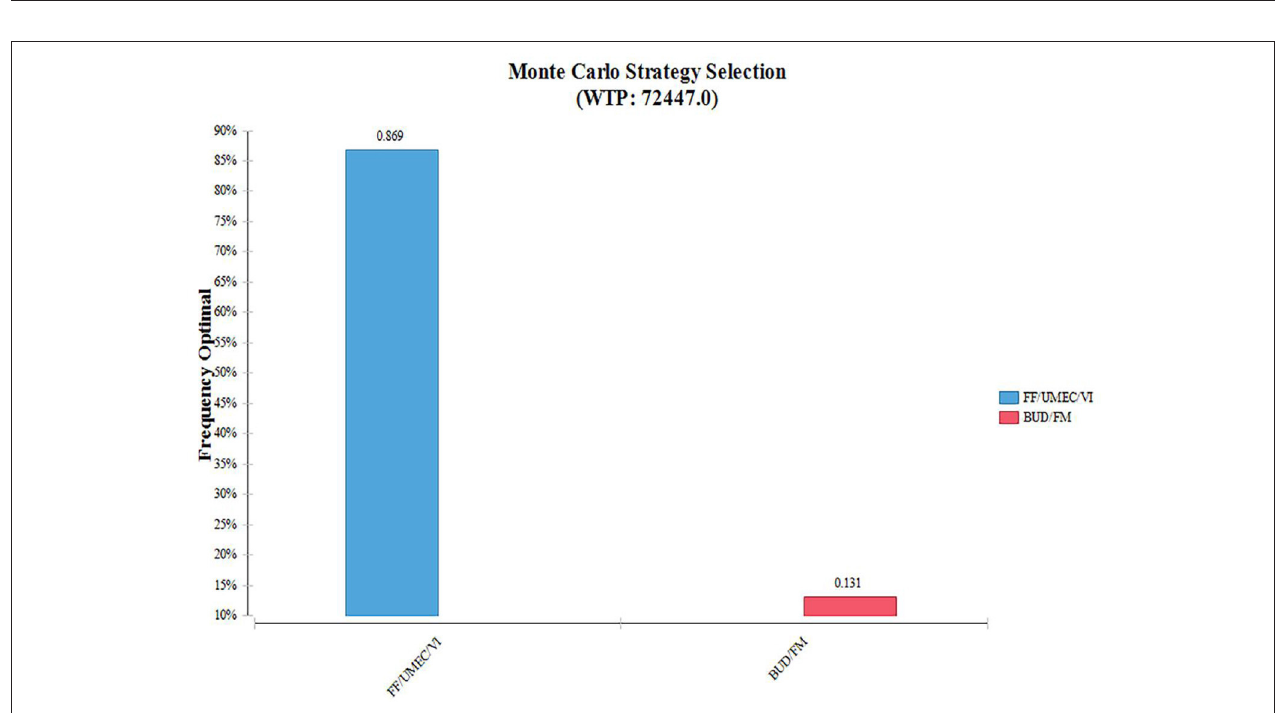
FIGURE 4 | Cumulative cost-acceptable probability of effect. FF/UMEC/VI, fluticasone/umeclidinium/vilanterol; BUD/FOR, budesonide/formoterol.